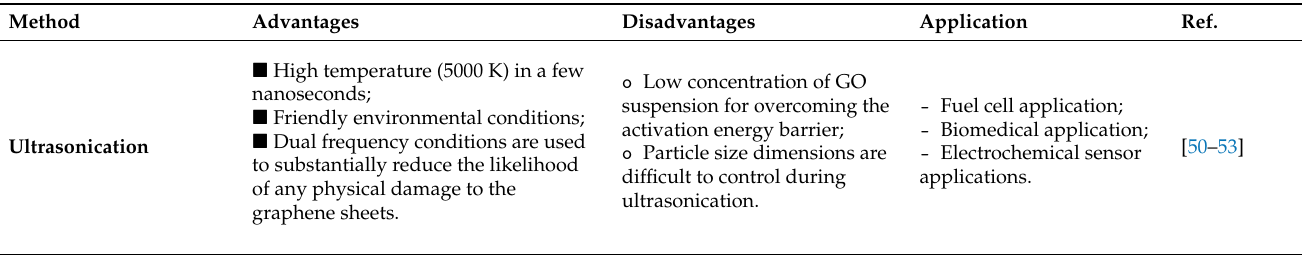
Table 2. Advantages and disadvantages of the synthesis methods of noble metals functionalized on graphene